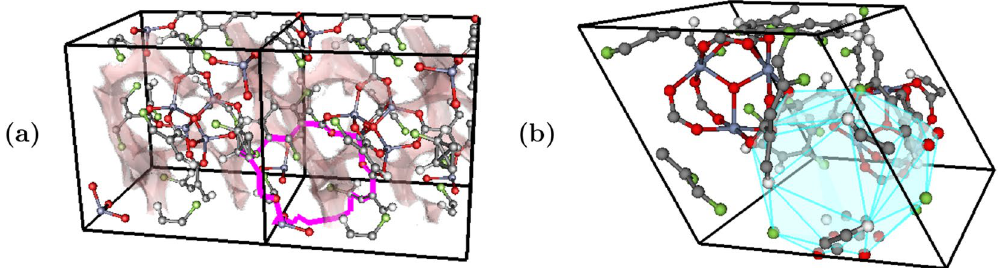
Figure 4. Example 1D and 2D representative cycles for different MOFs. ( a ) 1D channel, hMOF-675 (hMOFs) ( b ) 2D void, str-m4-o14-o14-acs-sym-5 (BW). The representative cycles are picked based on the approach described in Supplementary Fig. 3. Figure created with VisIt 3.1.4 (https:// wci. llnl. gov/ simul ation/ compu ter- codes/